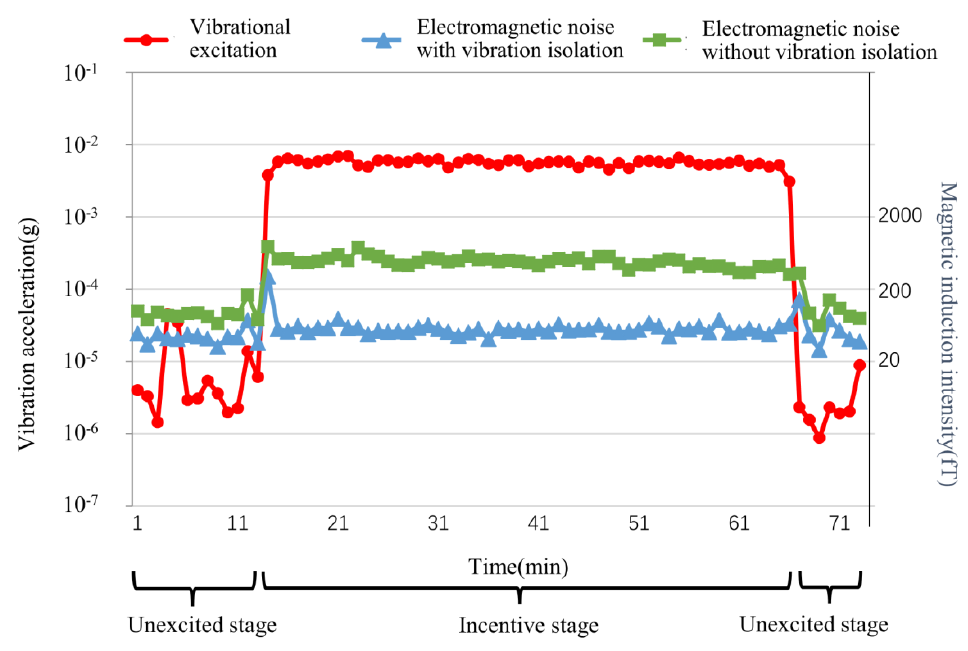
Figure 13. Environmental electromagnetic noise signal acquisition test results.